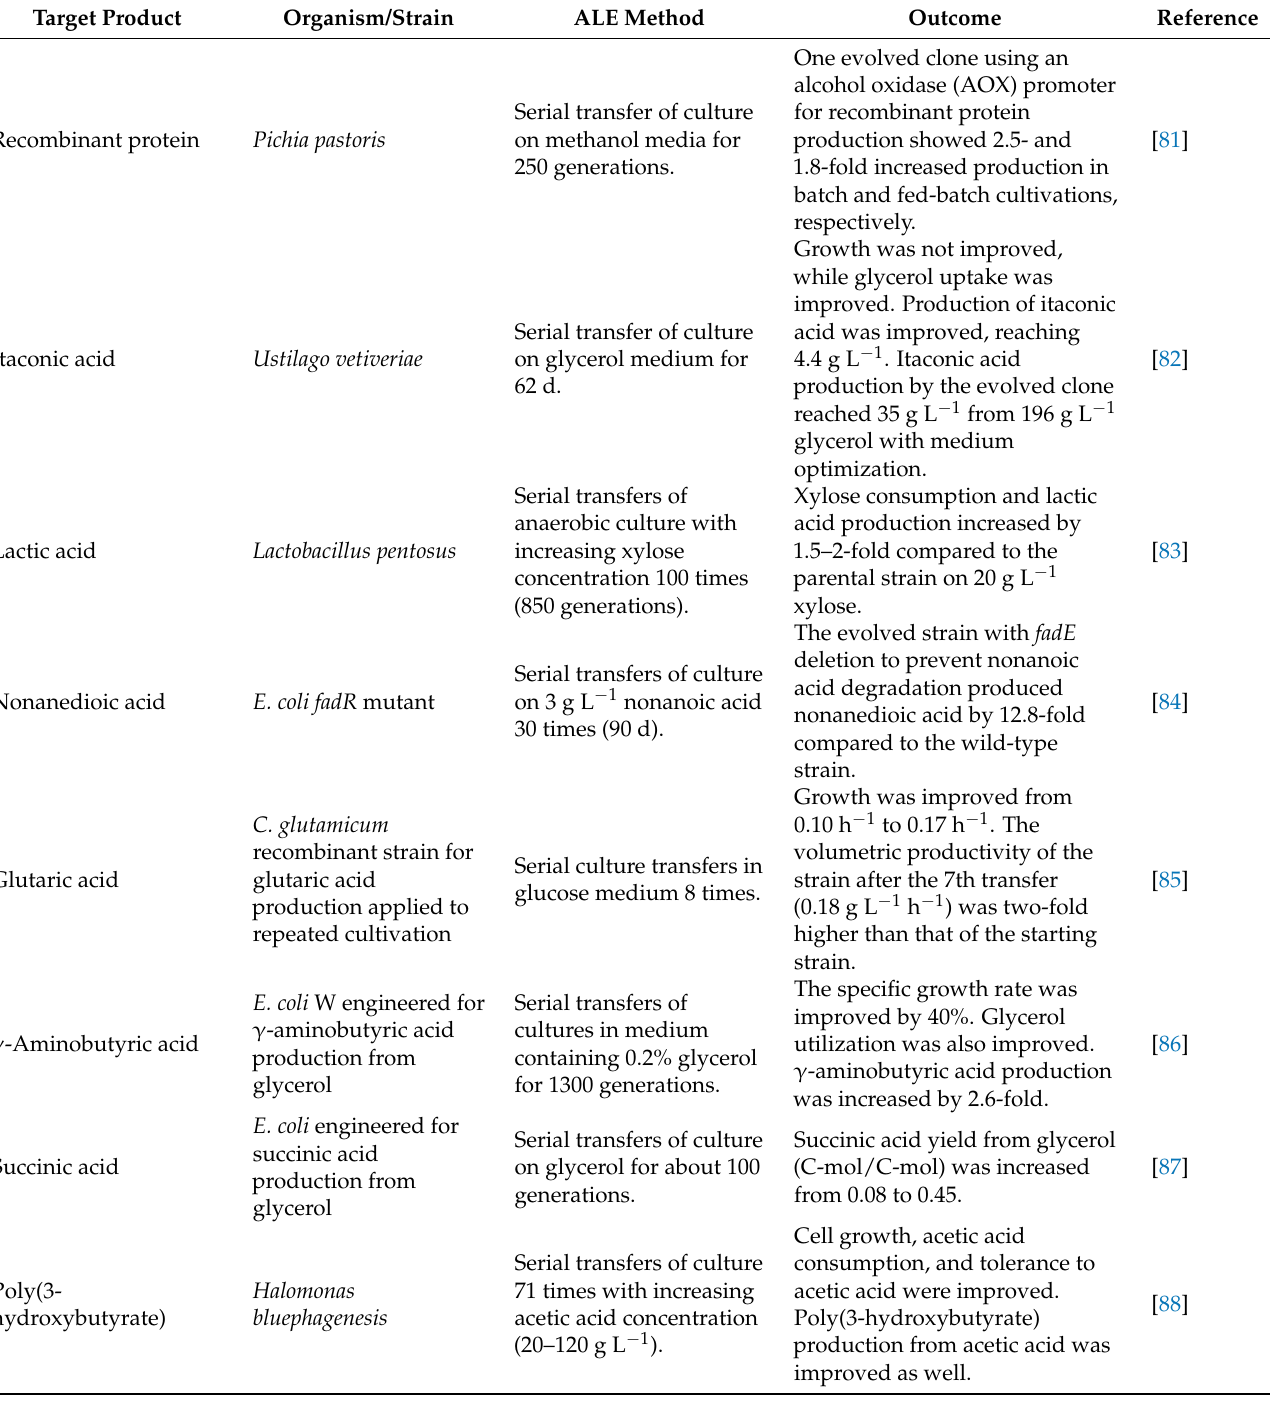
Table 4. Recent studies on ALE of microorganisms toward improved production of target